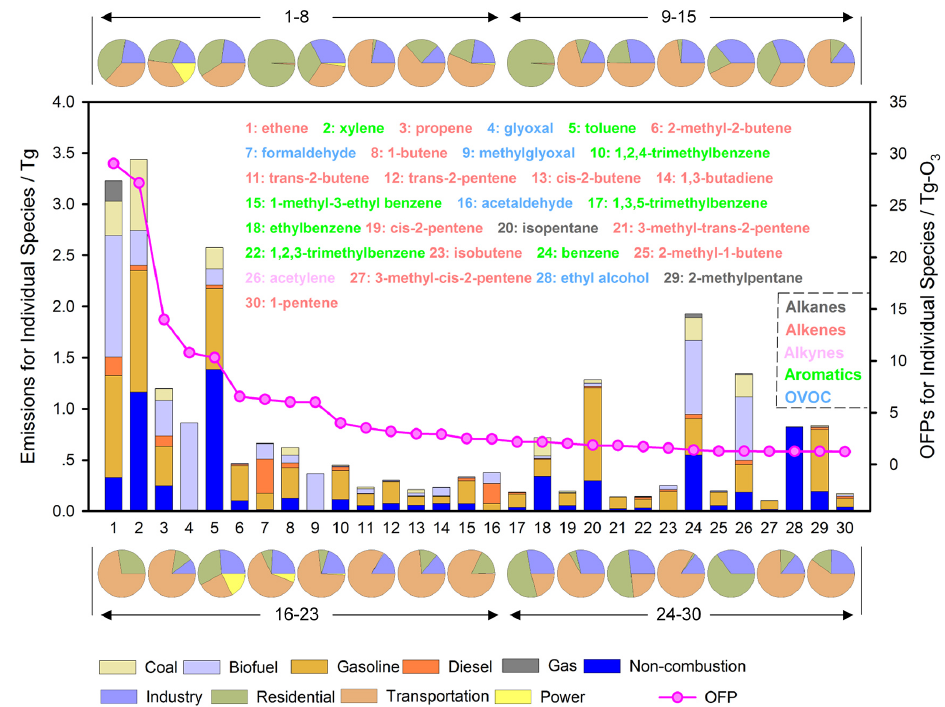
Figure 5. Emissions by individual NMVOC species and corresponding